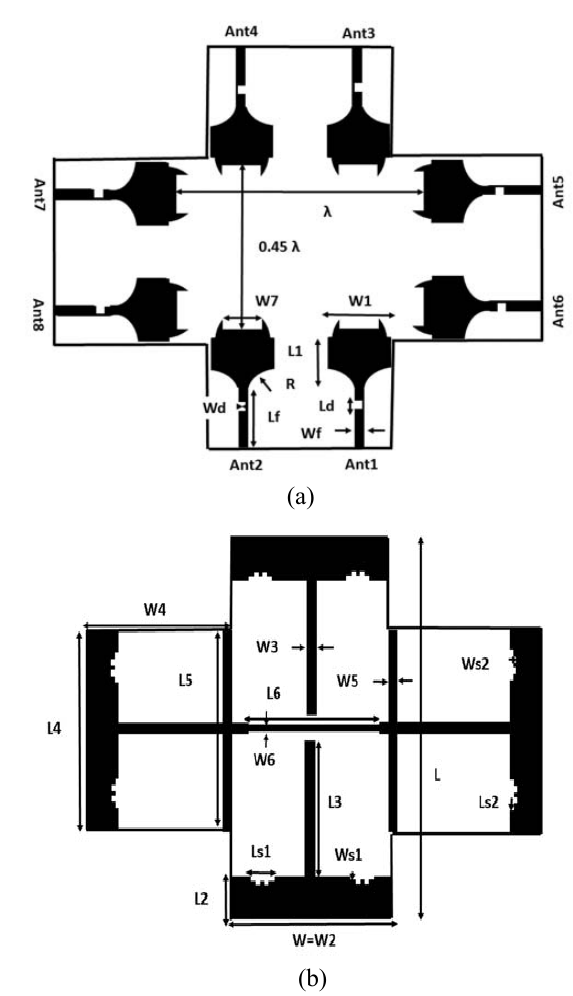
FIGURE. 7 The presented UWB eight-element MIMO antenna final design, (a) top face, (b) bottom face